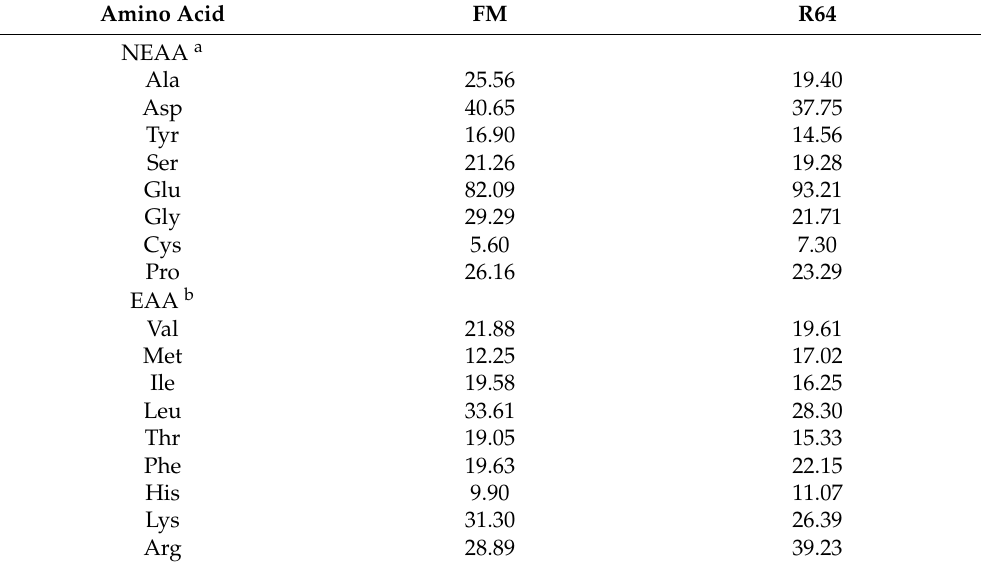
Table 3. Amino acid compositions of experimental diets (g/kg dry